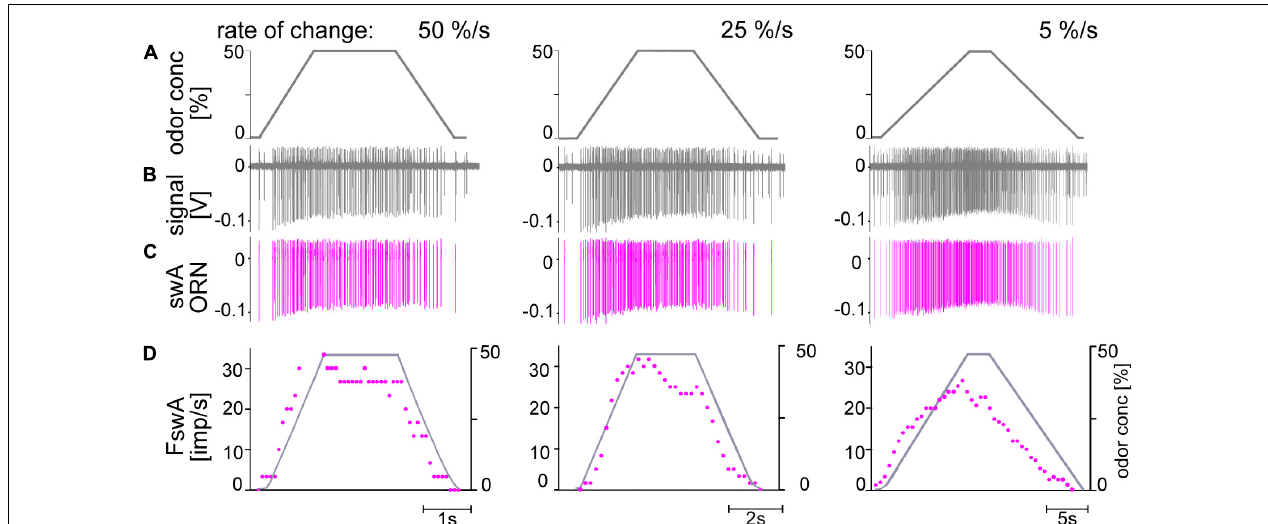
FIGURE 6 | (A–D) Simultaneously recorded responses of two ORN located in the swA sensillum to ramp-like concentration changes of odor of lemon oil. Ramp rates are 50, 25, and 5%/s. (A) Time course of odor concentration measured by flow meter. (B) Recordings from the swA sensillum showed activities of two ORNs. While the discharge of the ORN with the smaller impulse amplitude remained unchanged (not shown in detail), the ORN with the larger amplitudes ( pink ) is activated by the slow concentration changes. (C) Off-line sorted action potentials of the ORNs obtained by spike detecting and template matching techniques using Spike2